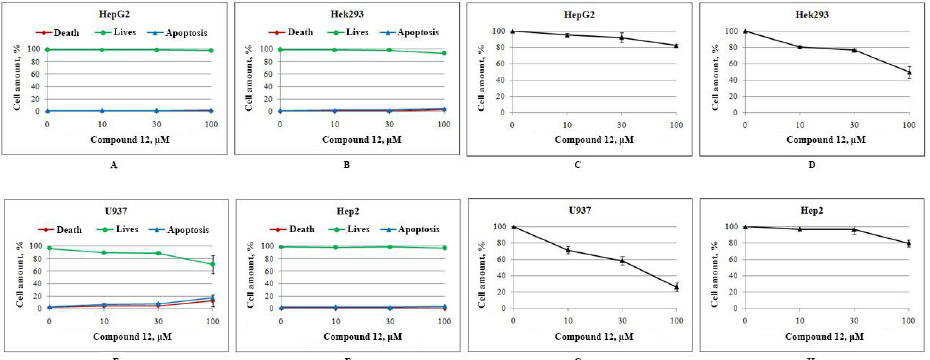
Figure 1. The influence of compound 12 on the viability of HepG2 (hepatocellular carcinoma) ( A ), Hek293 (fetal kidney) ( B ), U937 (histiocytic lymphoma) ( E ), and Hep2 (laryngeal carcinoma) ( F ) after 48 h of incubation. Change in the number of cells HepG2 ( C ), Hek293 ( D ), U937 ( G ), and Hep2 ( H ). Molecules 2020 , 25 , x FOR PEER REVIEW